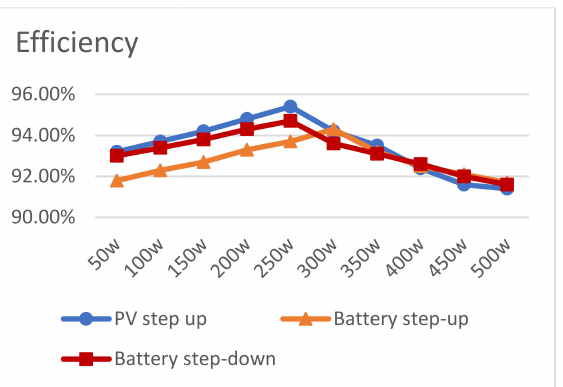
Figure 11. Efficiency curve of the proposed three-port bidirectional